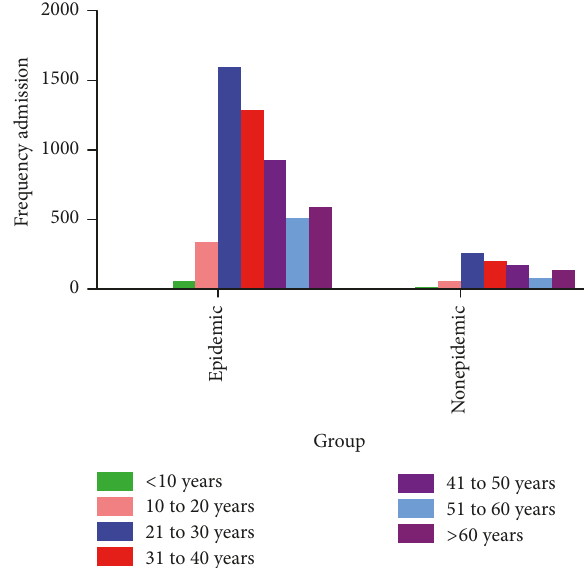
Figure 4: Frequency distribution of number of admissions during the epidemic and nonepidemic periods according to age